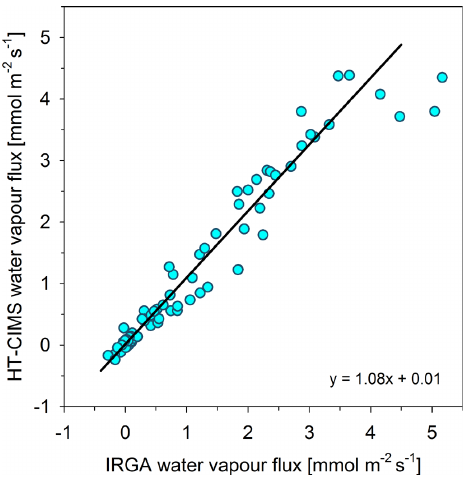
Fig. 11. Fluxes of water vapour measured by IRGA and HT-CIMS; Williamson-York bivariate fit (Cantrell, 2008).